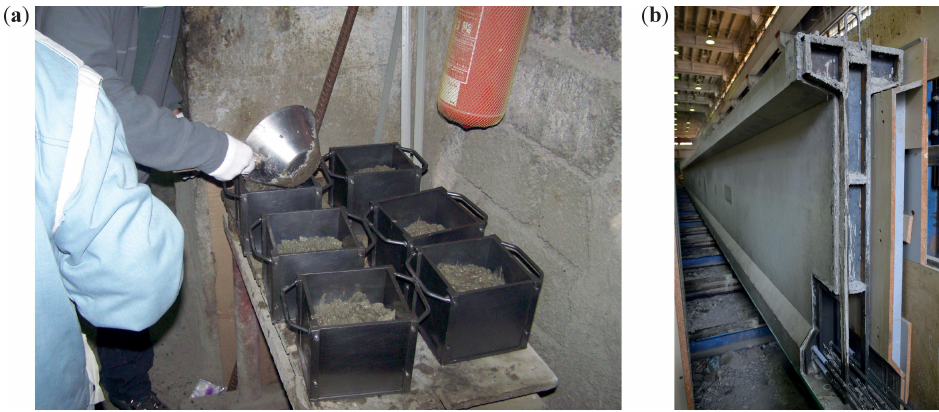
Figure 4. ( a ) making of the specimens; ( b ) manufacture of the V03 girders.